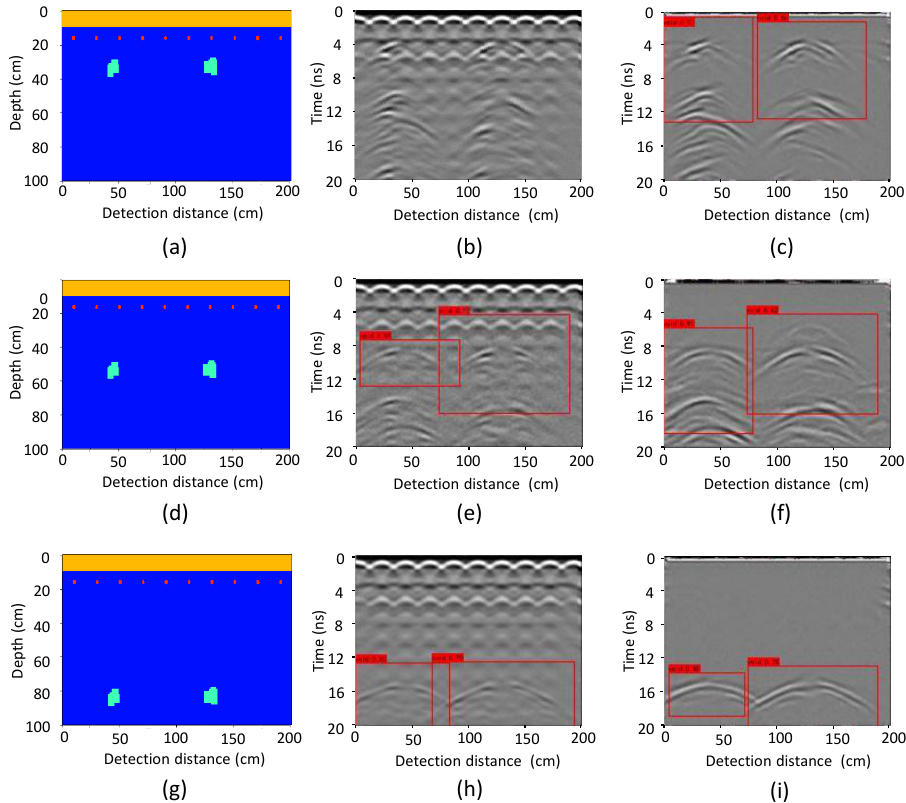
Figure 9. Detection results on testing dataset II. The three rows from top to bottom ( a - c ; d – f ; g – i ) represent three cases with rebar-void distance in the range of 0 to 30 cm, 30 to 60 cm, and over 60 cm, respectively. The left, middle, and right column denotes the FDTD permittivity models, YOLOv4 detection results on the original GPR images, and on the RCE-GAN processed images,